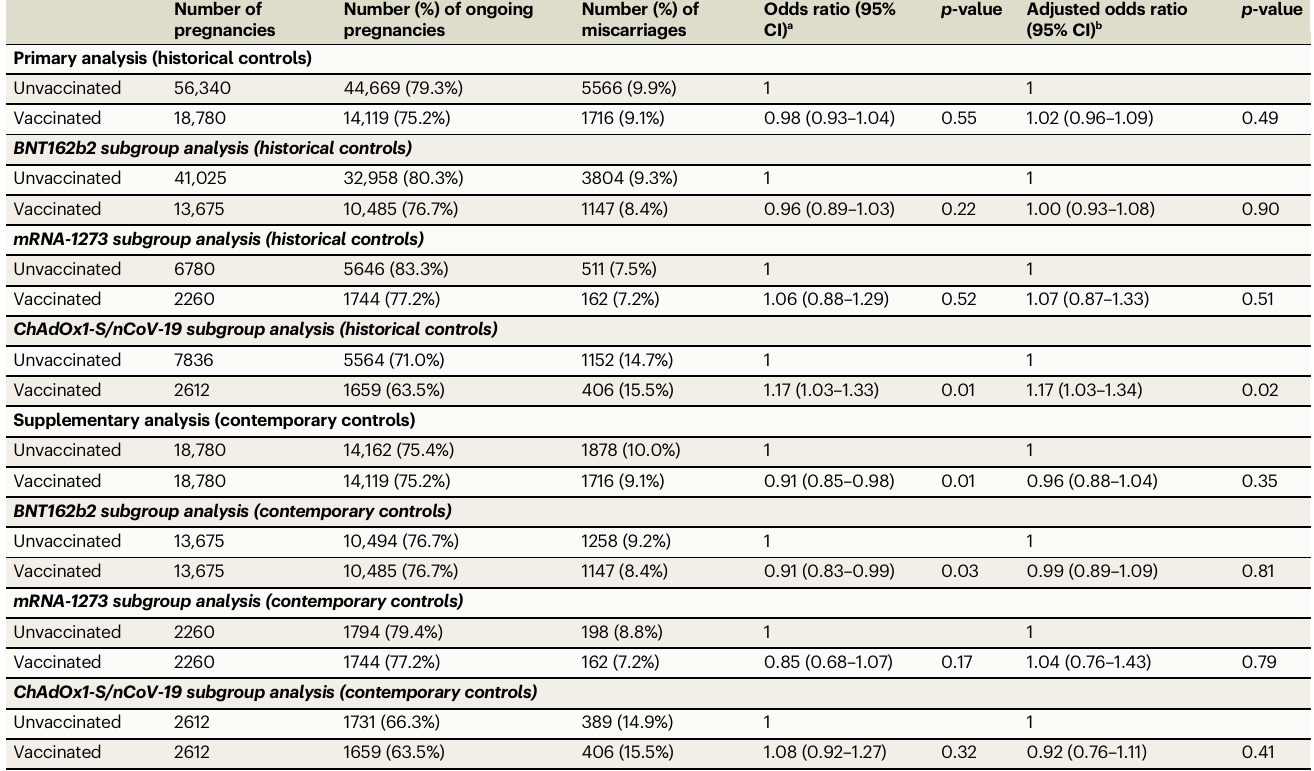
Table 2 | Odds ratios for the association between COVID-19 vaccination and miscarriage from multinomial logistic regression models Number of